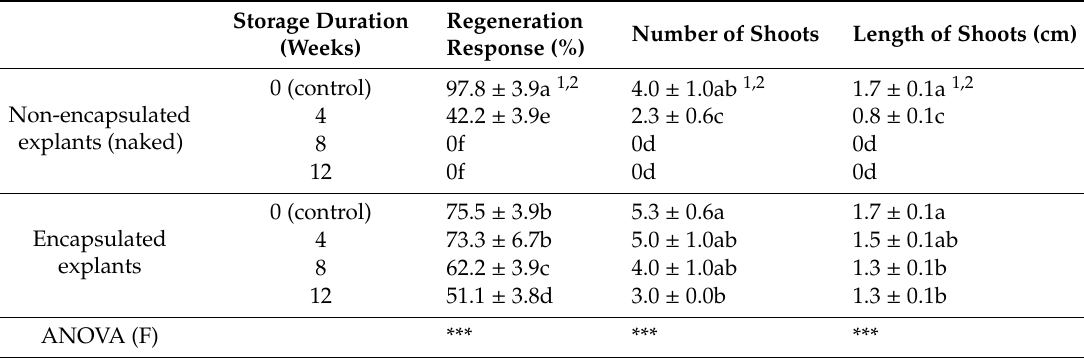
Table 5. Influence of cold storage (4 ◦ C) duration on subsequent regeneration of encapsulated and non-encapsulated shoot tip explants of Viburnum dentatum on solid MS nutrient medium with 5 µ M of